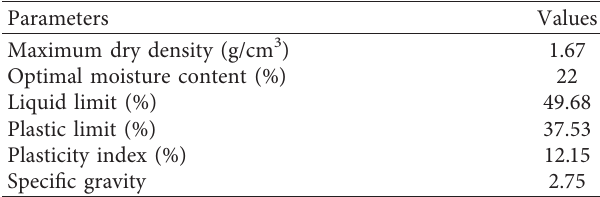
Table 1: Physical parameters of red